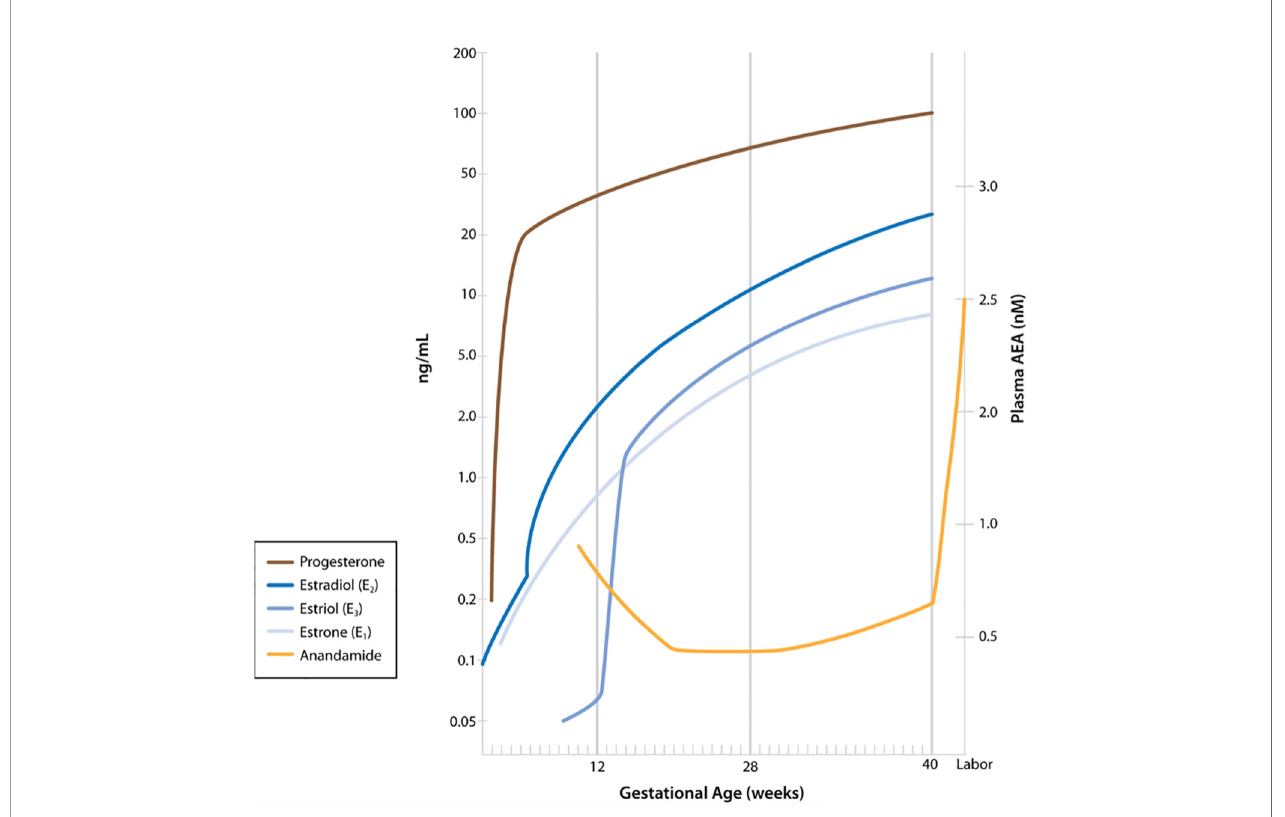
FIGURE 1 | Maternal plasma anandamide levels as described by Habayeb and colleagues (14) relative to levels of progesterone and estrogens during pregnancy. (Figure including levels of progesterone and estrogens published in Boron WF, Boulpaep EL: Medical Physiology, 3 rd ed. Philadelphia, Elsevier, 2017. Data from Wilson JD, Foster DW, Kroenber M, Larsen PR: Williams Textbook of Endocrinology, 9 th ed. Philadelphia, WB Saunders, 1998. Used with